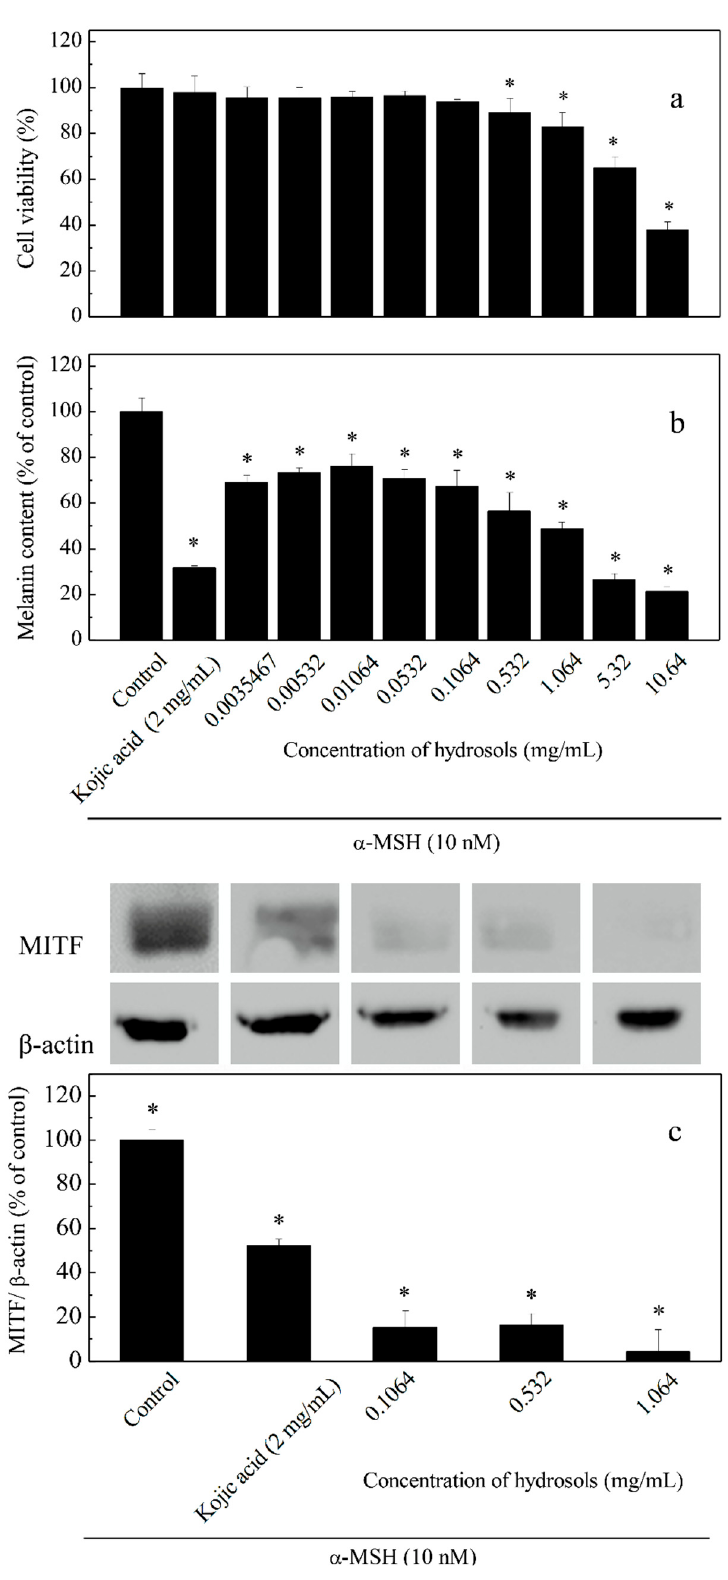
Figure 5. E ff ects of hydrosol concentrations on cell viability ( a ), melanin contents; ( b ) and expression levels of tyrosinase and microphthalmia-associated transcription factor (MITF); ( c ) in α -melanocyte-stimulating hormone -treated B16-F10 cells. Data are presented as means ± SD from three independent experiments; * p < 0.05 compared with the untreated group.